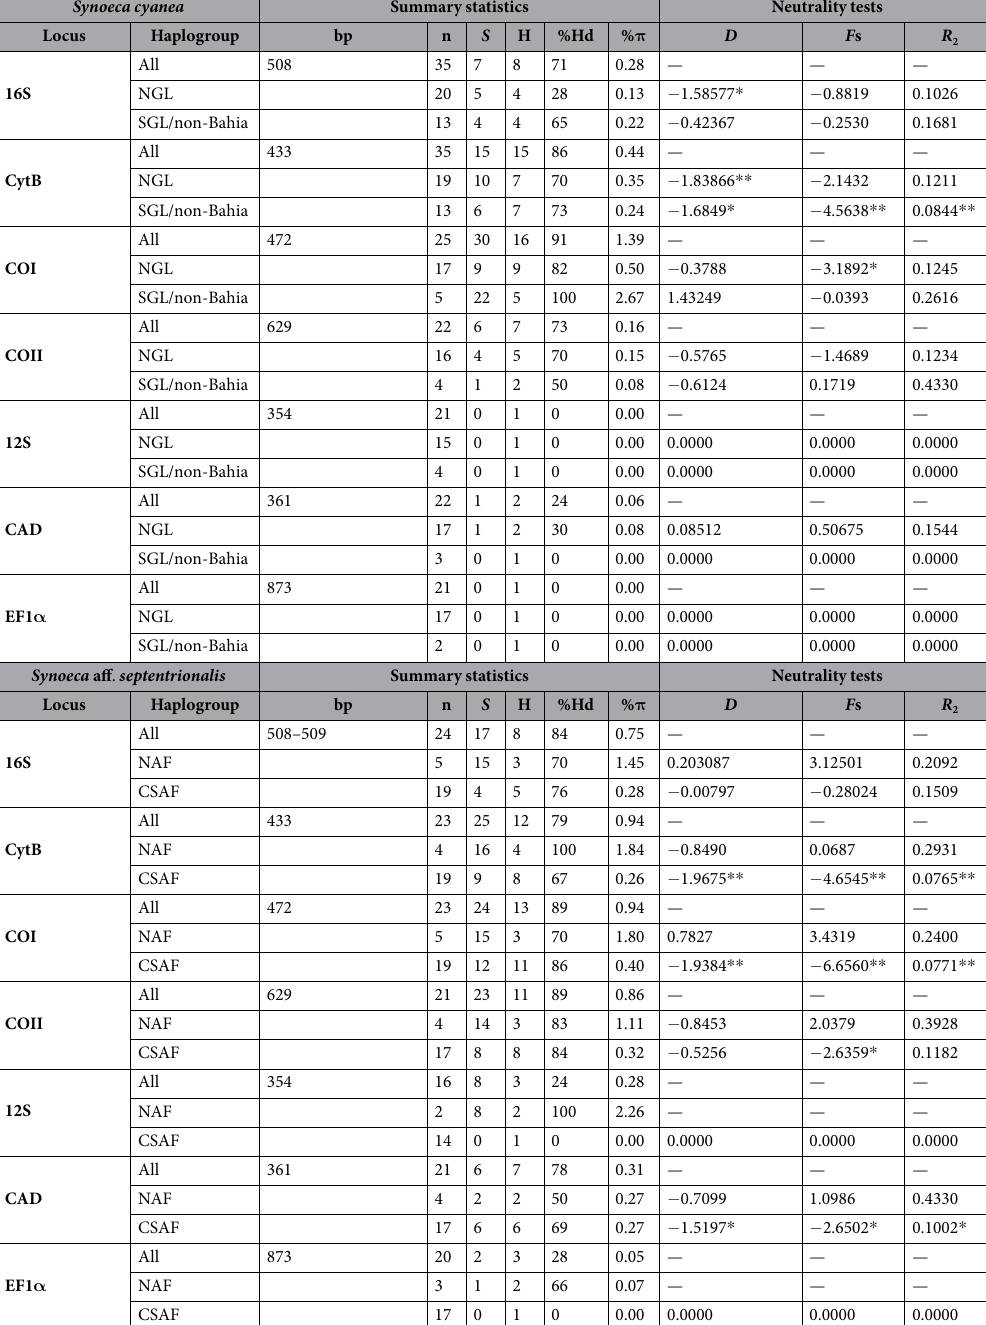
Table 1. Genetic diversity and neutrality tests for the two armadillo wasps. Sample size (n), nucleotide diversity in percent (% π ), number of polymorphic/segregating sites ( S ), number of haplotypes (H), haplotype diversity